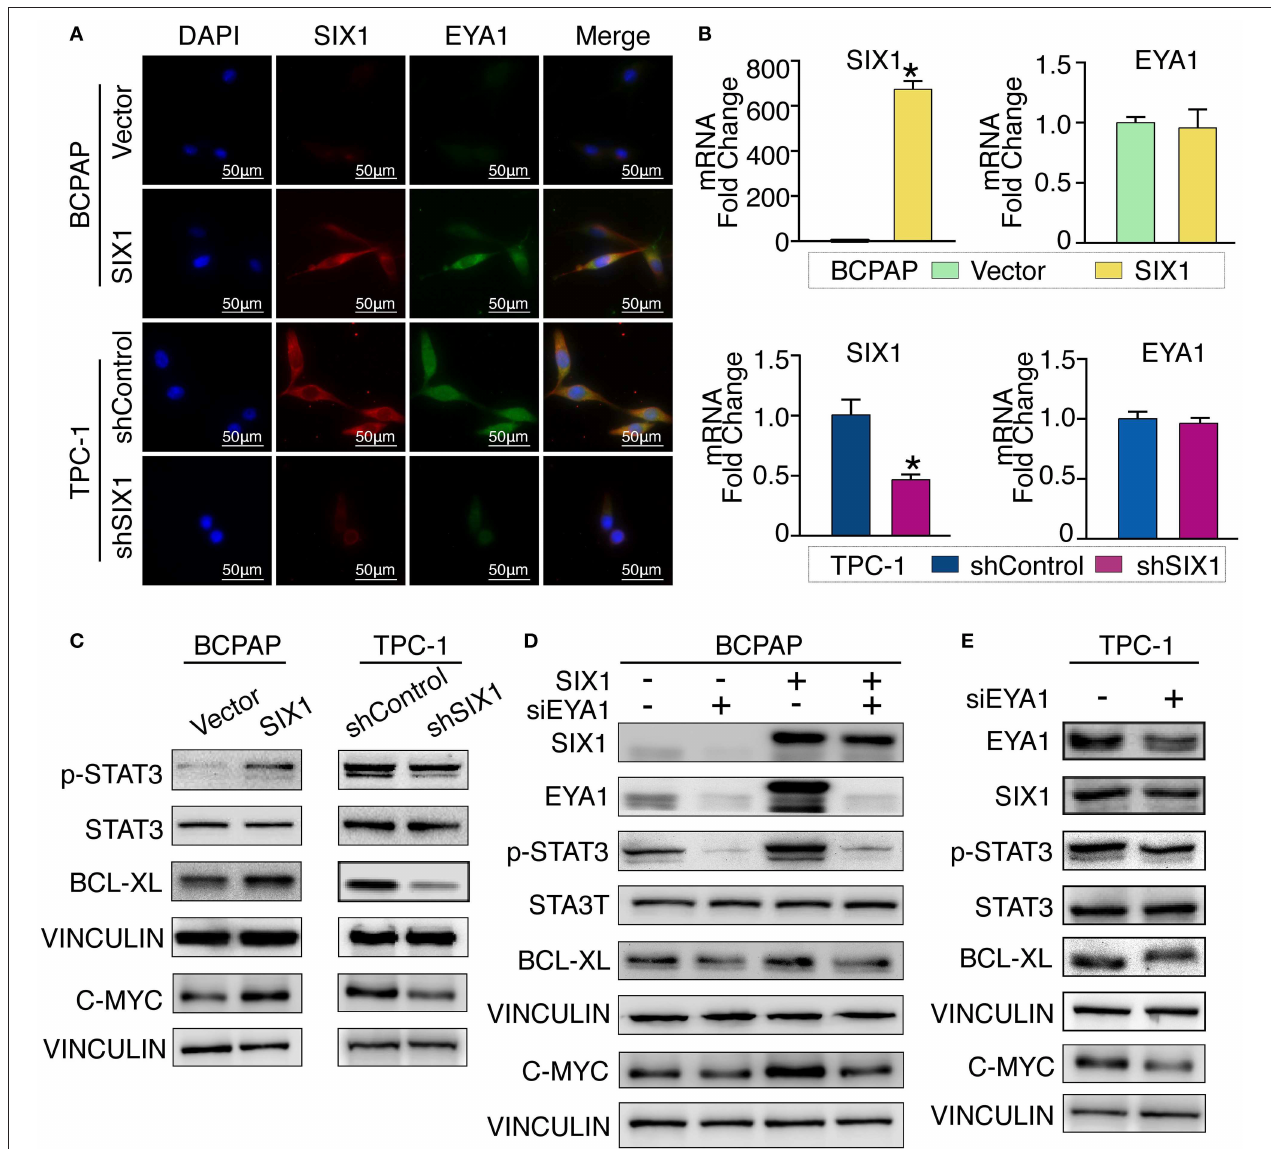
FIGURE 5 | SIX1 activated STAT3 signaling pathway to promote PTC cells proliferation via EYA1. Immunofluorescence show the co-localization of SIX1 (red) and EYA1 (green) (A) . The relative mRNA level of SIX1 and EYA1 in PTC cell lines with SIX1 overexpression or silencing (B) . Western blot analysis of indicated protein from PTC cells with SIX1 overexpression or silencing (C) . Western blot analysis of indicated protein from BCPAP cells with SIX1 and/or EYA1 silencing (D) . Western blot analysis of indicated protein from TPC-1 cells with EYA1 silencing (E) . * p <